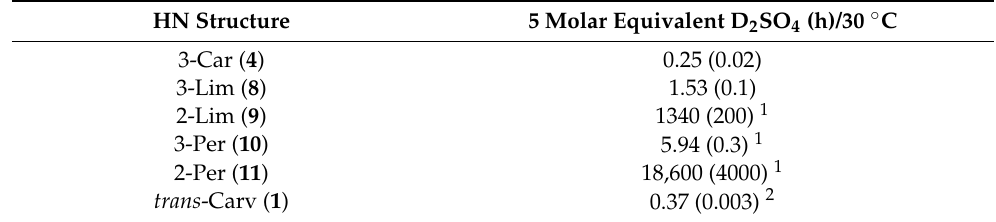
Table 2. Lifetimes (hours) of HN conversion at 30 ◦ C in acidified 25% D 2 O/DMSO- d 6 . Uncertainties, given in parentheses, represent one standard deviation from triplicate